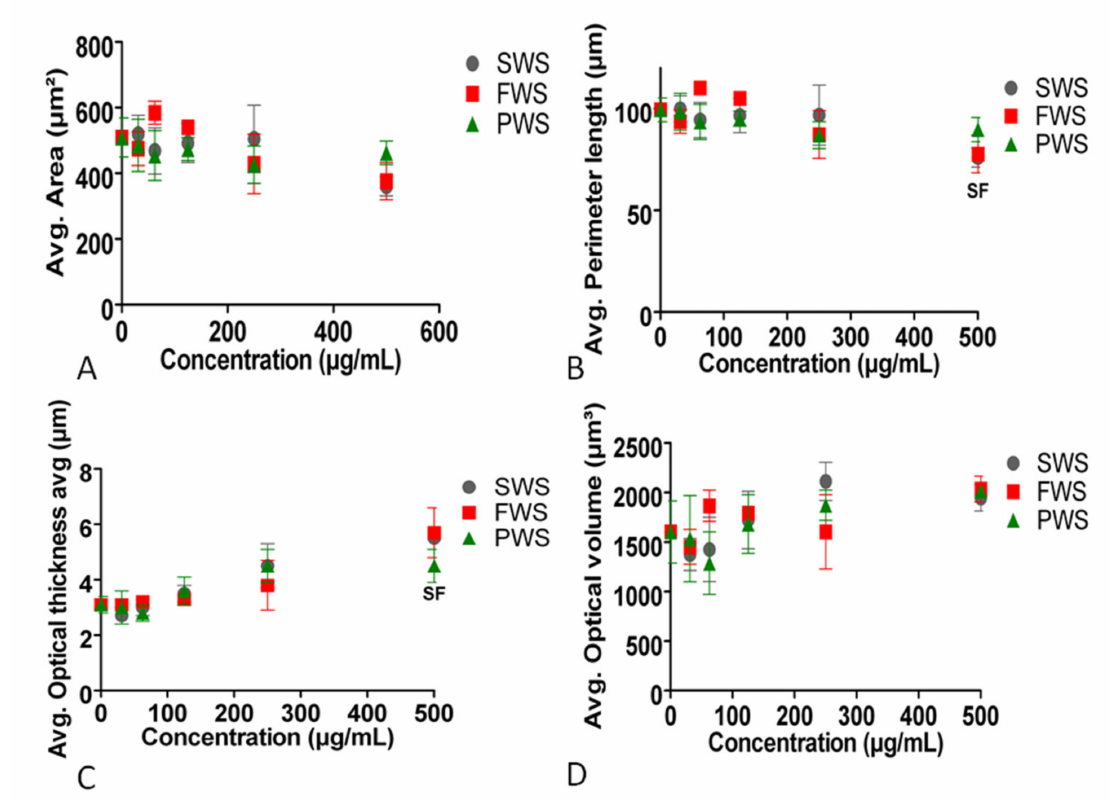
Figure 4. Effects of three types of water-soluble particulate pollutants from biomass burning on ( A ): area, ( B ): perimeter length, ( C ): optical thickness, and ( D ): optical volume of A549 cells. Significant differences at p ≤ 0.05 between the particles and the control are represented by F for FWS and S for